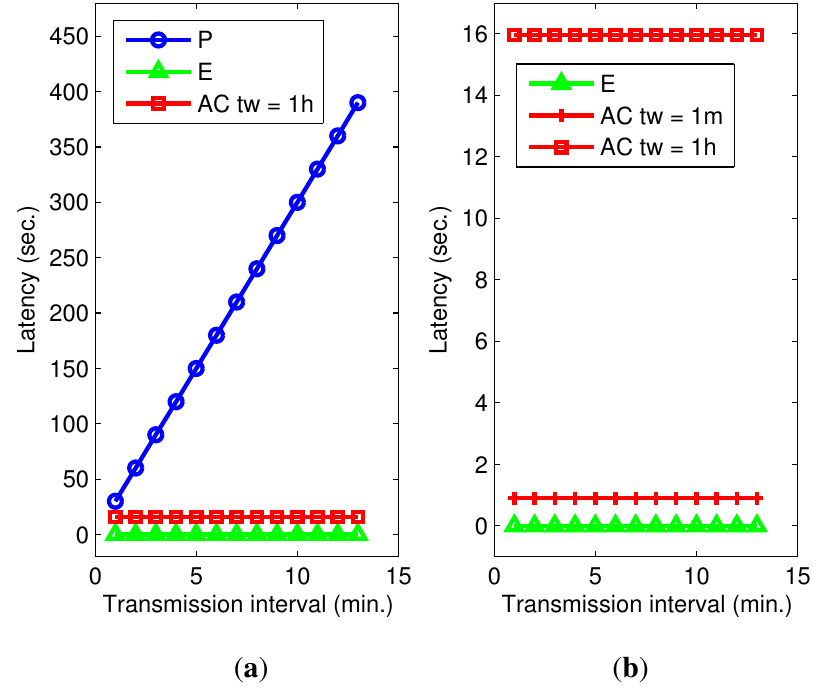
Figure 7. Latency of privacy protection